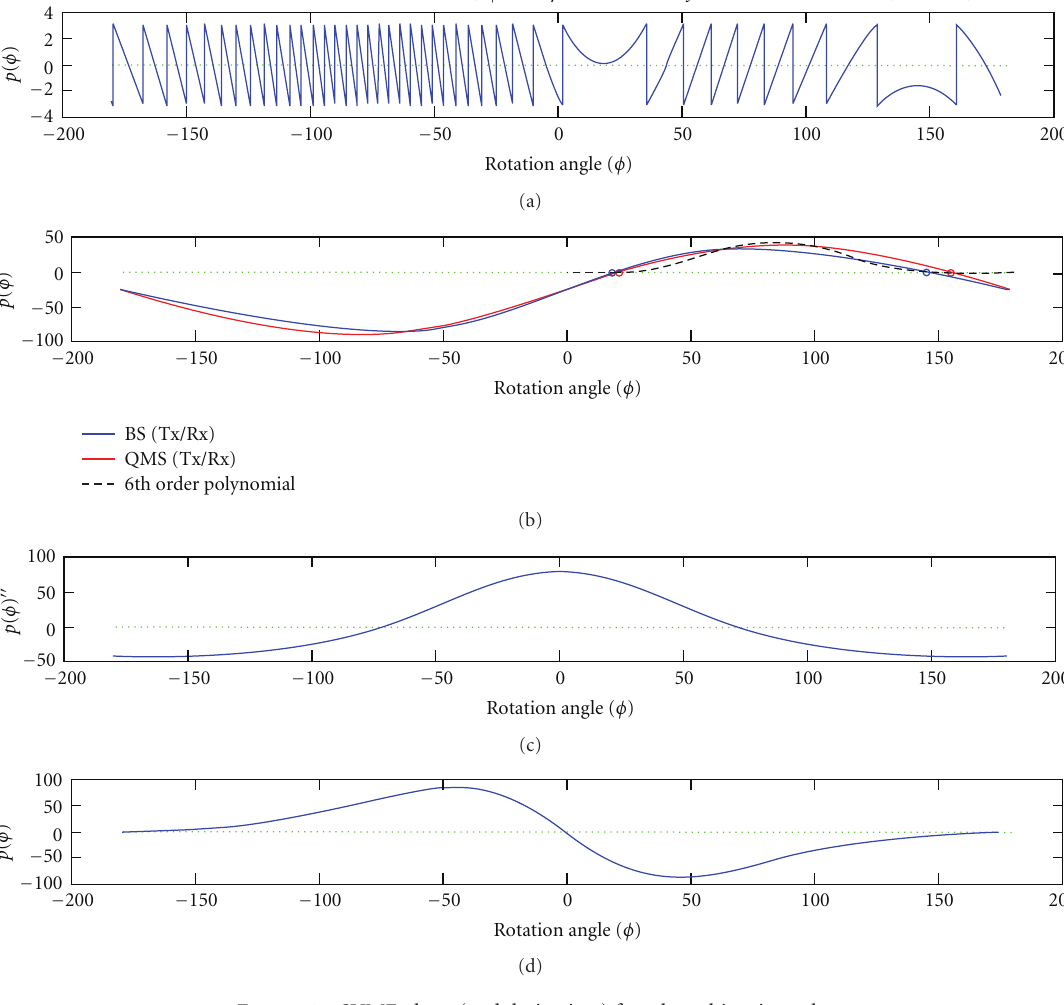
Figure 15: SVMF phase (and derivatives) for a large bistatic angle.